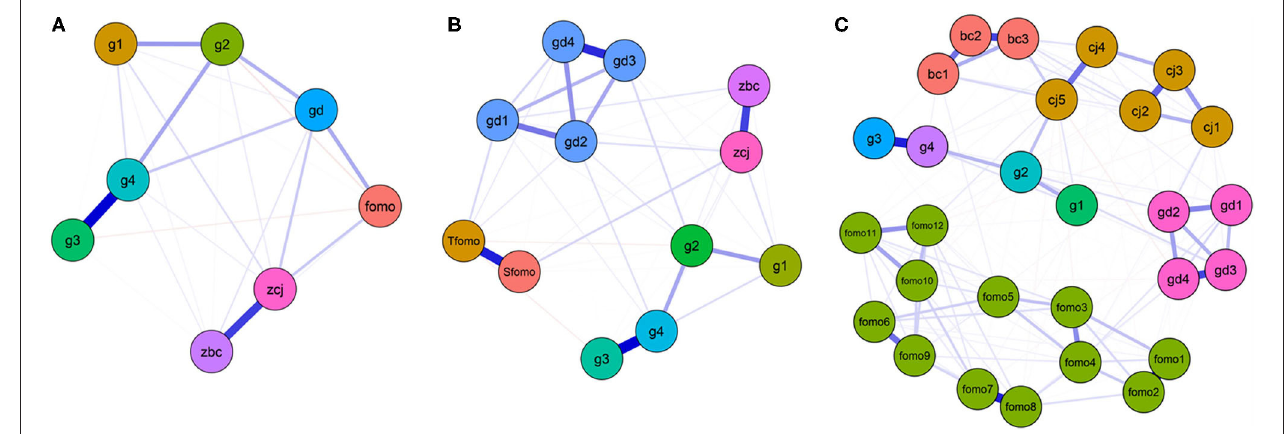
FIGURE 1 | EBICglasso model based on network analysis according to the relationships between gaming disorder (GD), compensation motivation, game flow, time spent gaming, and fear of missing out (FoMO) among 1,635 participants in domain-level network (A) , in facet-level network (B) , and in item-level network (C) . gd, gd1 ∼ gd4, Gaming disorder; zbc, bc1 ∼ bc3, self-compensation motivation; zcj, cj1 ∼ cj5, game flow; fomo, fomo1 ∼ fomo12, FoMO; Tfomo, trait-FoMO; Sfomo, state-FoMO; g1 ∼ g4, game